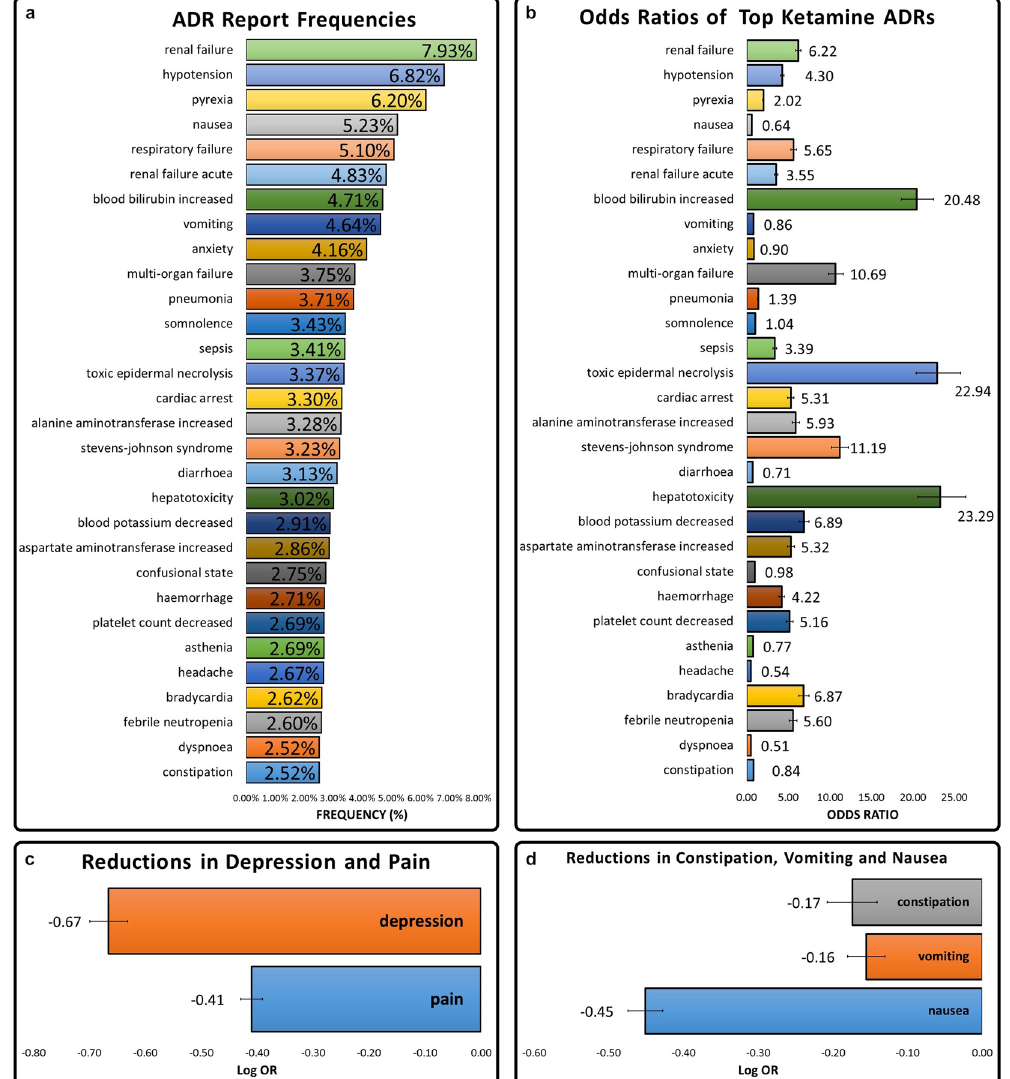
Figure 1. Legend: ( a ) Frequencies of adverse events in patients on FAERS who took ketamine. Adverse events above 2.5% were reported. ( b ) Odds ratios were calculated comparing adverse event rates of ketamine patients (n = 41,337) and pain patients (n = 238,516). ( c ) LogOR of pain and depression event rates were calculated from the ketamine and pain patient cohorts. Negative values showing protective effect of ketamine. ( d ) LogOR of constipation, vomiting, and nausea were calculated from the ketamine and pain patient cohorts. Negative values showing protective effect of